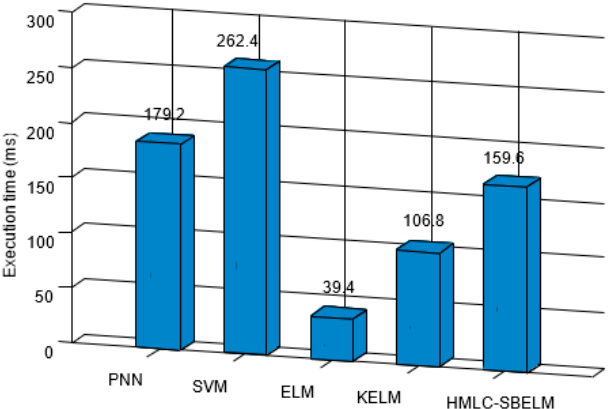
Figure 11. Comparison of the execution time.